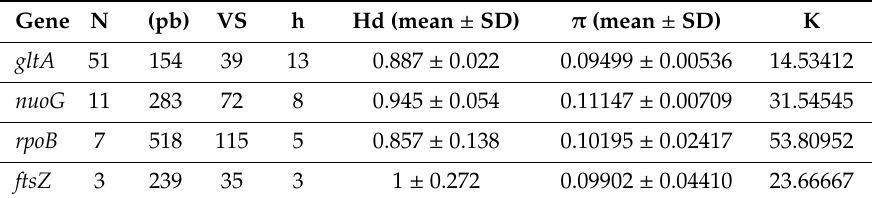
Table 3. Polymorphism found among the sequences obtained from ectoparasite and bat blood samples for each gene analyzed in the present